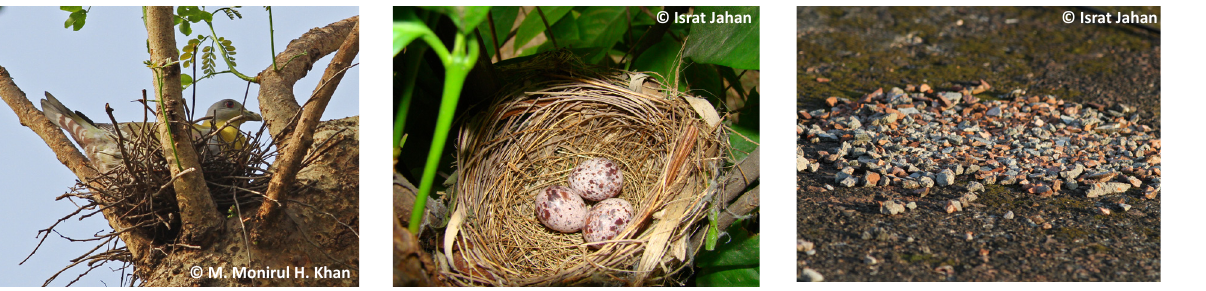
Image 2. Small Minivet nest